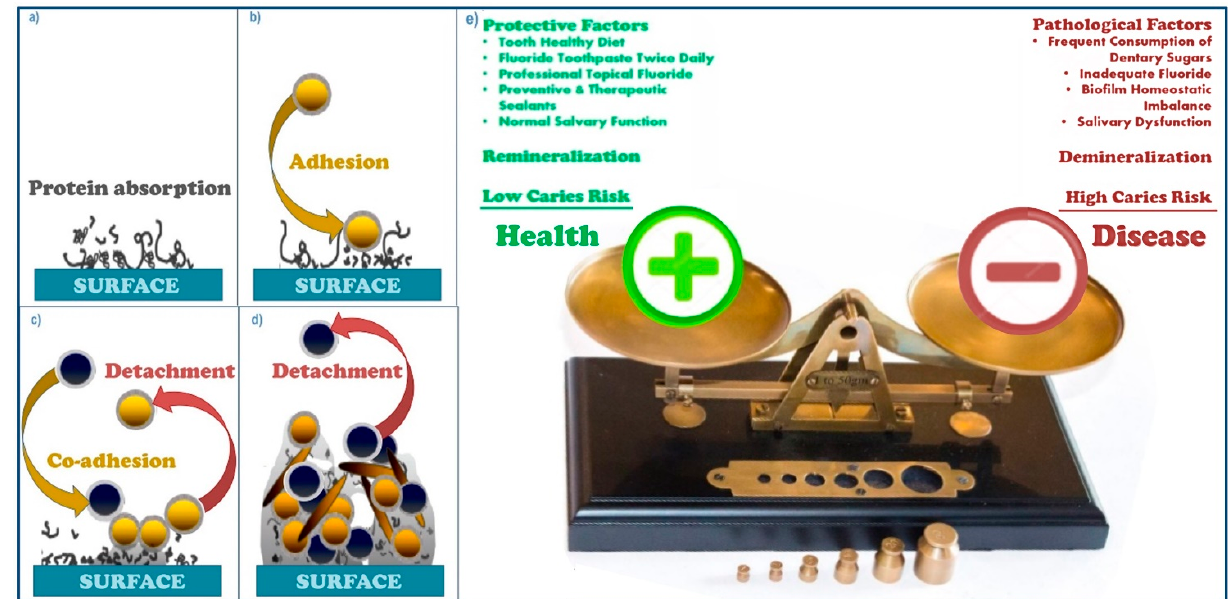
Figure 1. ( a – d ) Scheme of stages of bacterial biofilm formation: ( a ) adsorption of proteins forming a conditioning film; ( b ) adhesion of planktonic bacteria; ( c ) adhesion and detachment of planktonic bacteria; ( d ) growth and metabolism by adherent bacteria. ( e ) The dynamics of interactions between protective and pathological factors that can shift the balance in the oral cavity towards health or disease.